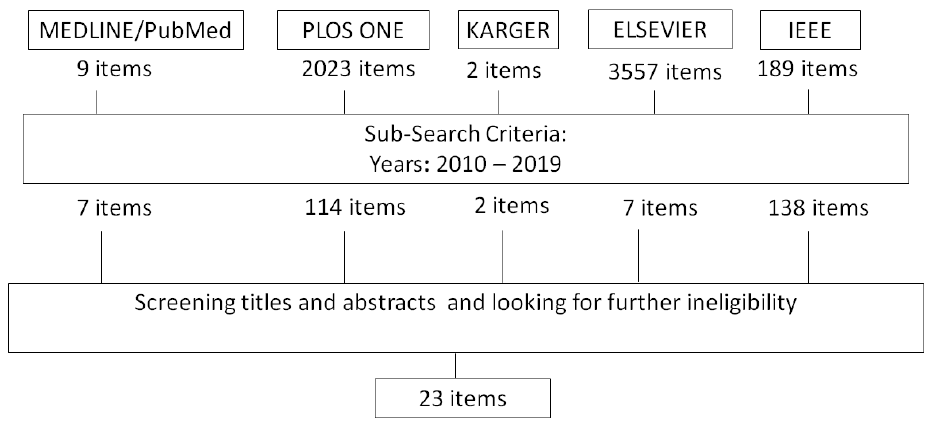
Figure 1. Results of Search and Screening